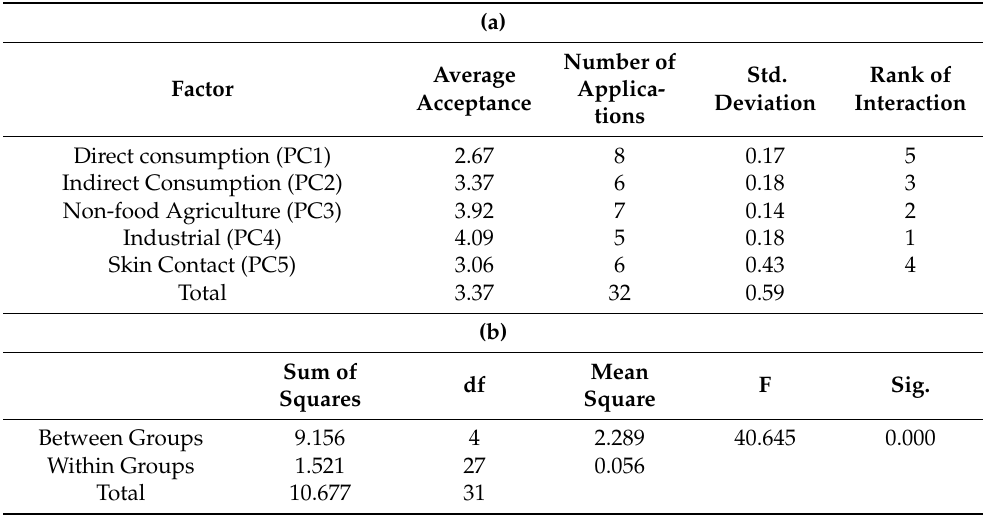
Table 6. ( a ) Average acceptance by principal component; ( b ) One-Way ANOVA for the association between TWW applications’ main factor and application average